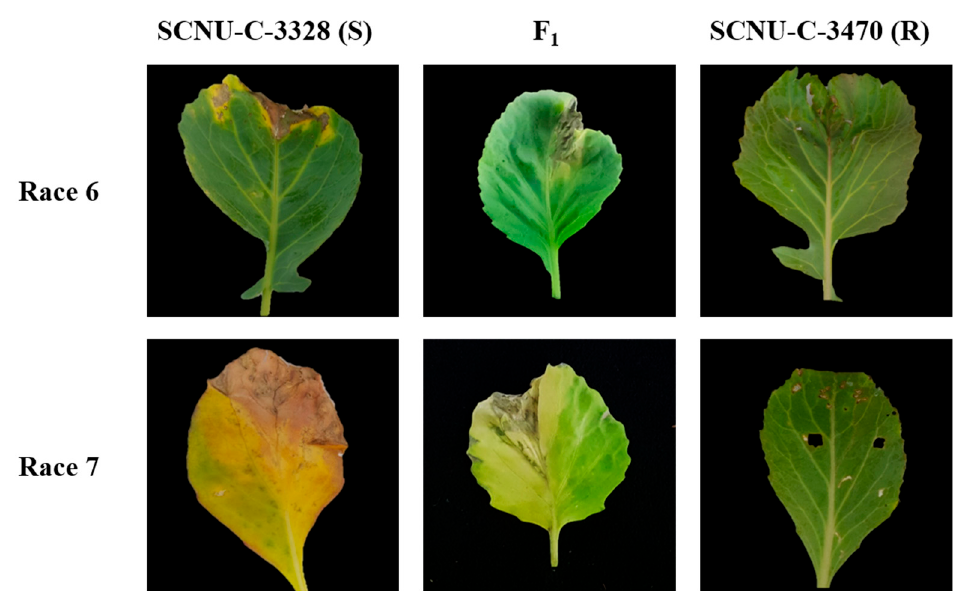
Figure 1. Phenotypes of the resistant and susceptible, and their F 1 generation two weeks after inoculation with Xanthomonas campestris pv. campestris ( Xcc ) races 6 and 7. Table 1. Inheritance of Xcc races 6 and 7 resistance in cabbage. S; susceptible, R; resistant. Crosses Generation Susceptible Resistant Race 6